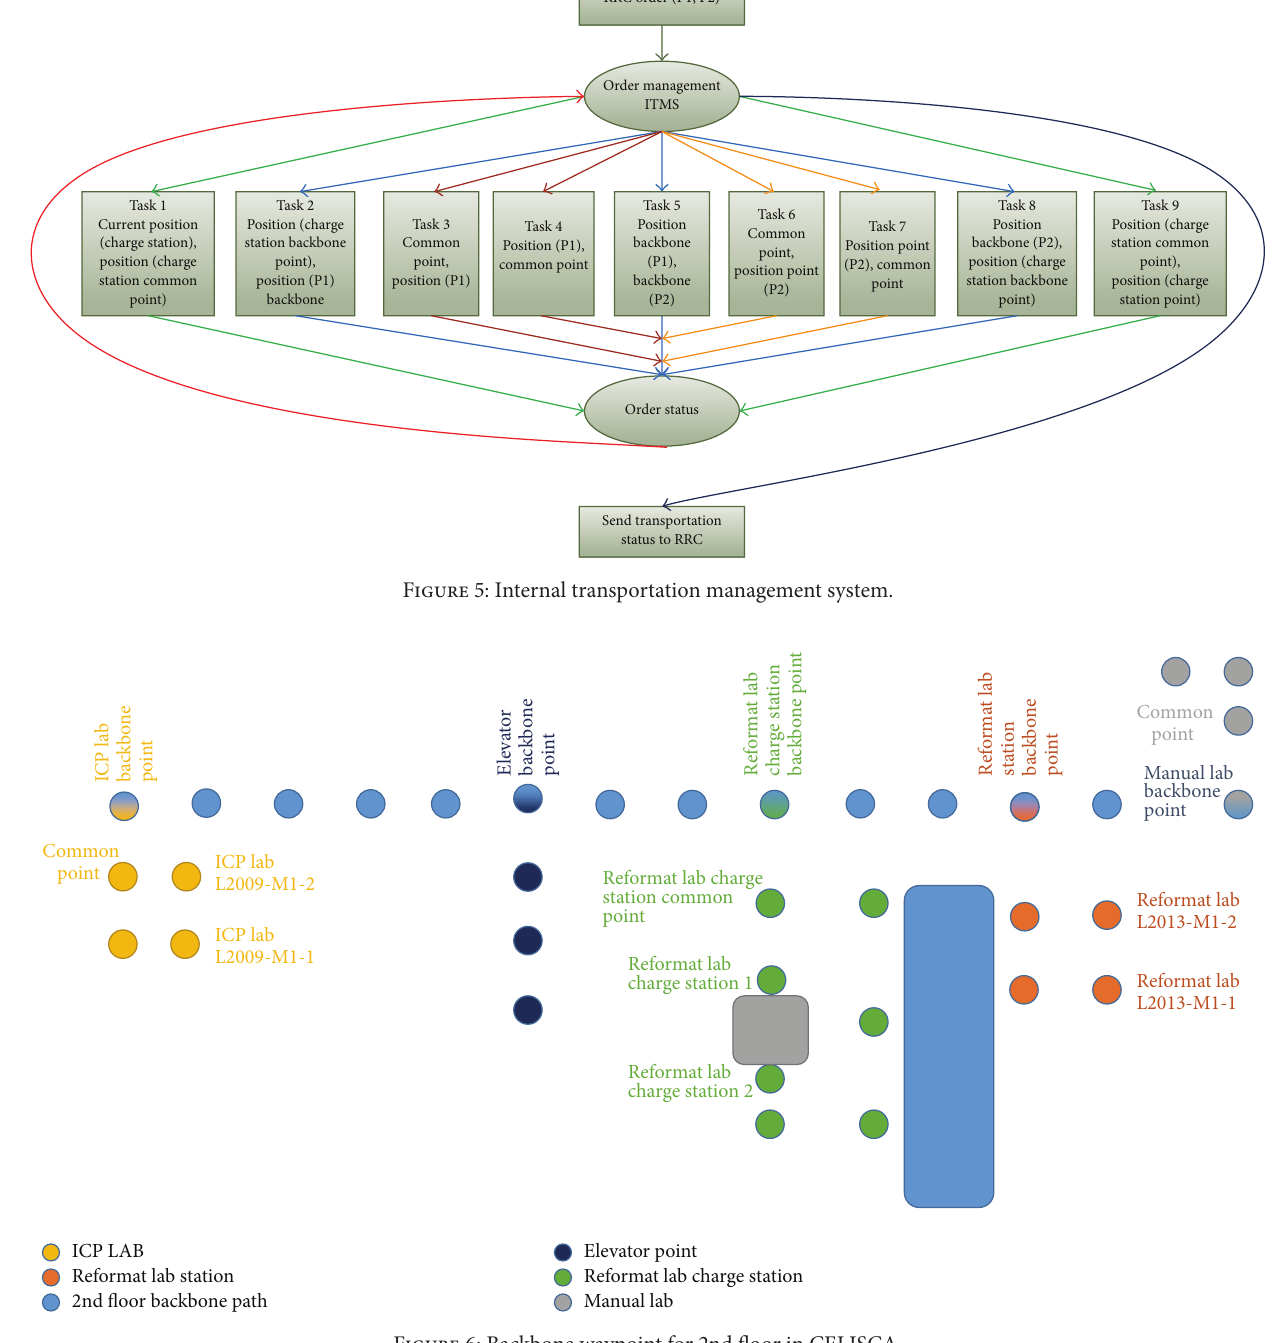
Figure 6: Backbone waypoint for 2nd floor in